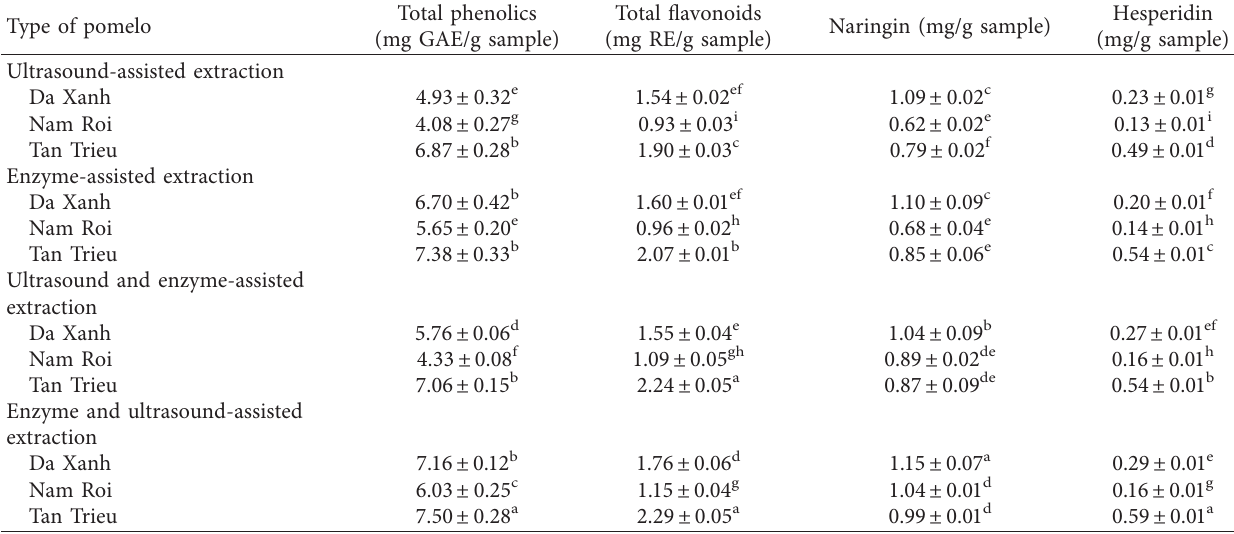
Table 1: Total phenolic, flavonoid, naringin, and hesperidin contents of extracts from pomelo peels using different extraction methods 1 .